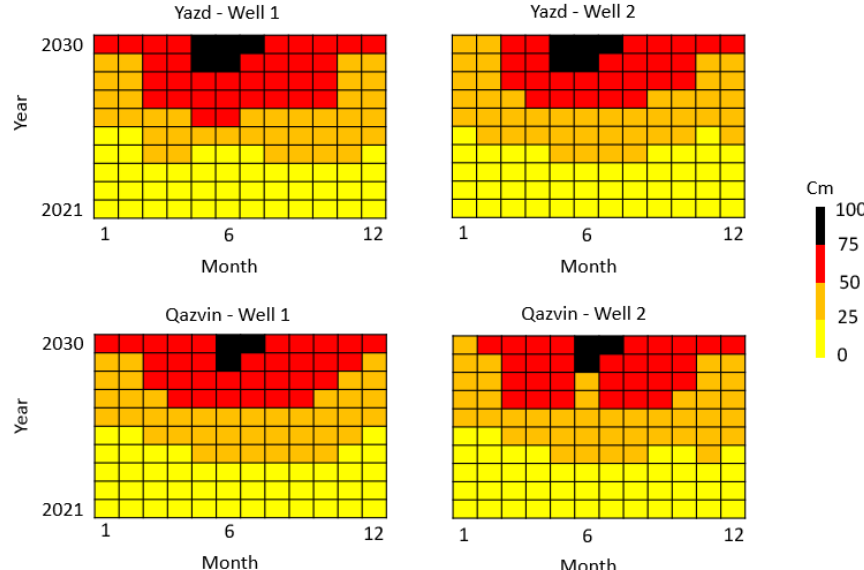
Figure 14. Heatmap plot of difference between monthly average of predicted groundwater level depth over 2021 to 2030 and base period . Table 9. Correlation coefficient between changes in groundwater level and meteorological parame-